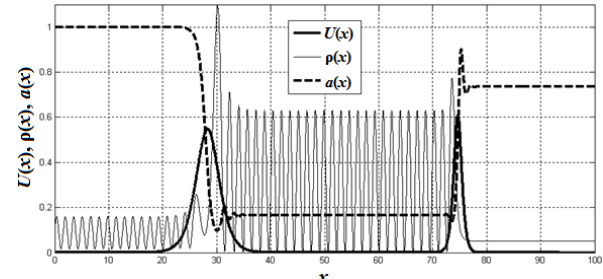
Figure 2: Result of numerical solution of Schrödinger differential